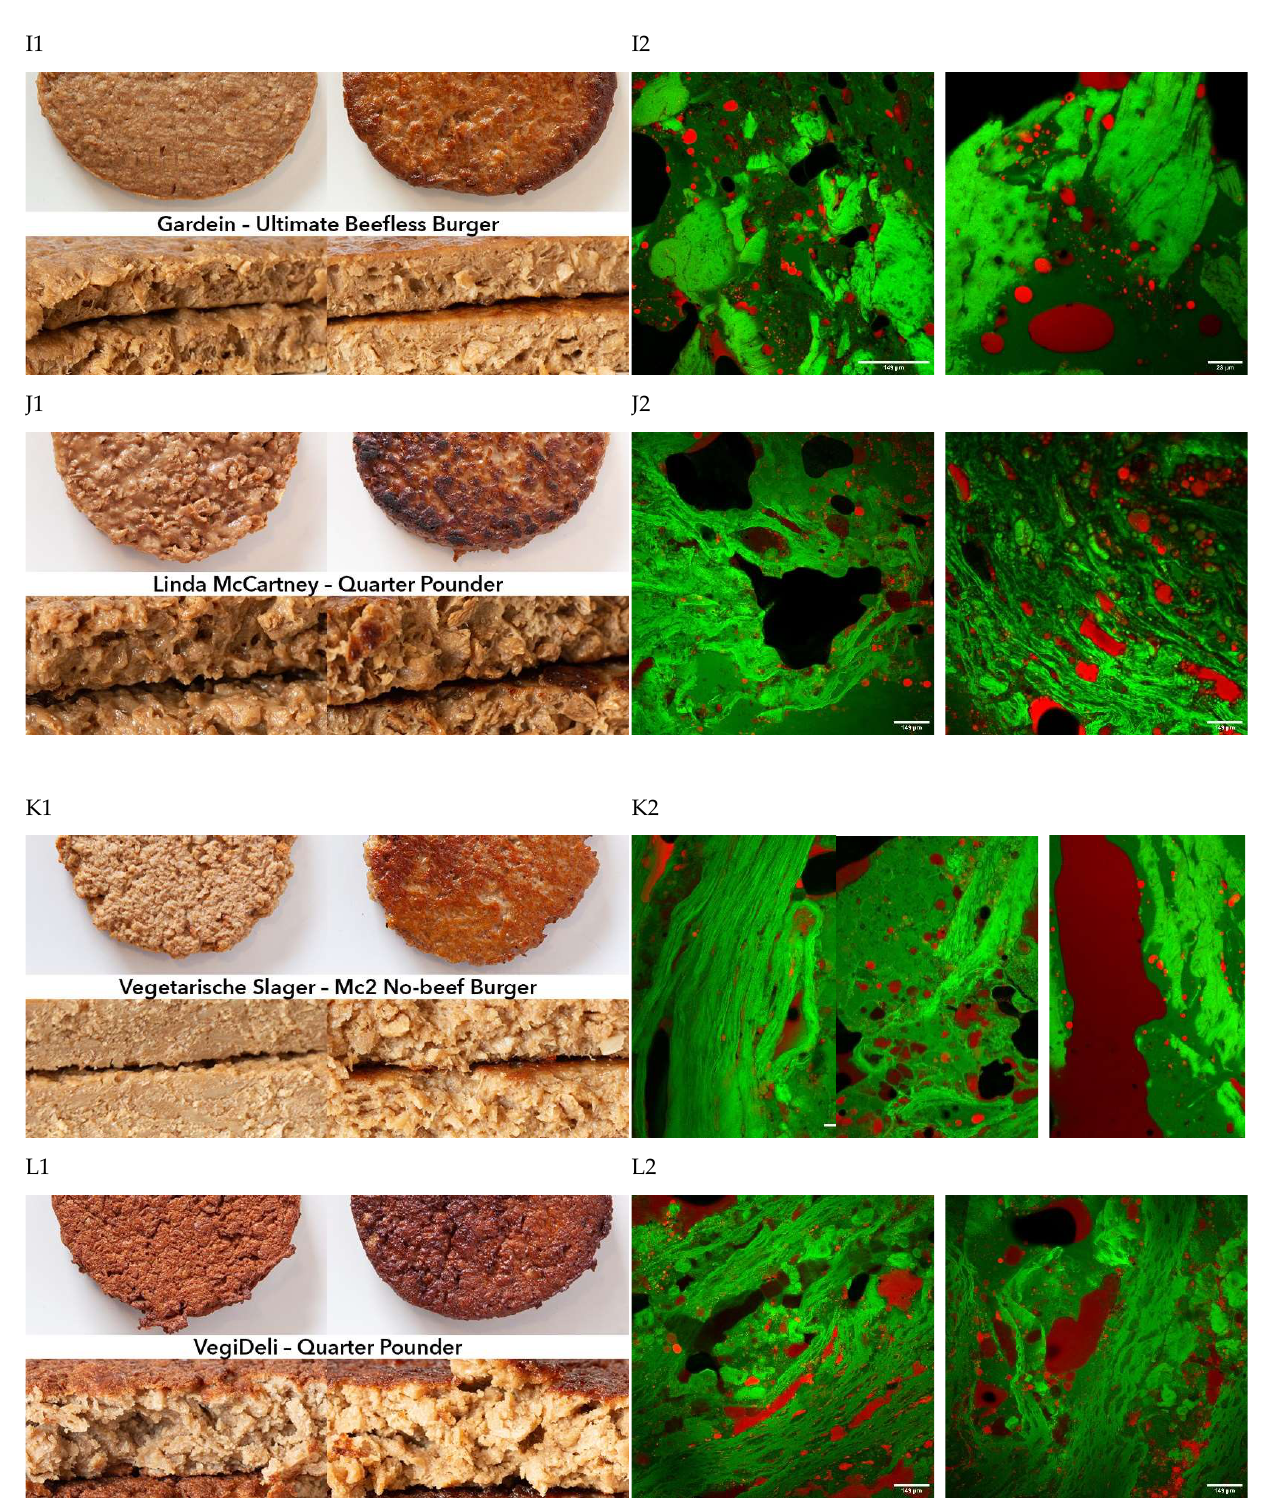
Figure 1. Top view and cross section of raw (left) and baked (right) products. CLSM. Pictures of the appearance of a selection of meat replacers ( A–L ) studied in the present research (left, 1) and CLSM micrographs of the same samples (right, 2). In the left column, the top 2 pictures are taken from the top of the products, while the lower pictures are taken from the front when the products were cut. In the right figure, representative CLSM images are given, with either a scale bar of 149 or 23 µ